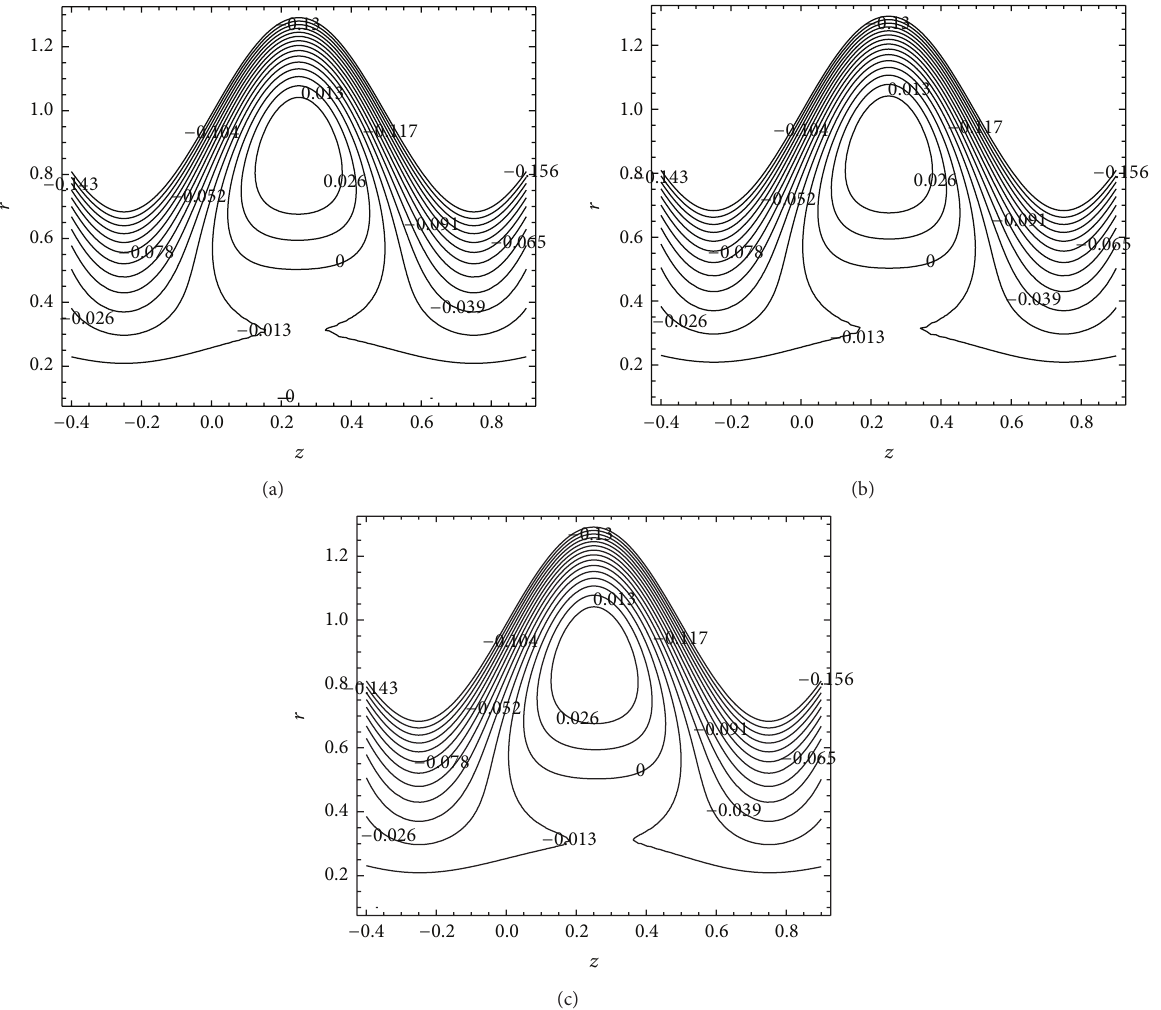
Figure 18: Graph of streamlines for different three values of Wi: (a) Wi = 0 , (b) Wi = 0.04 , (c) Wi = 0.08 at 𝜖 = 0.1 , 𝑄 = 0.7 , 𝛿 = 0.156 , Re = 0.1 , and 𝜙 = 0.3 , 𝑟 ∈ [𝜖, 𝑟 2 ]